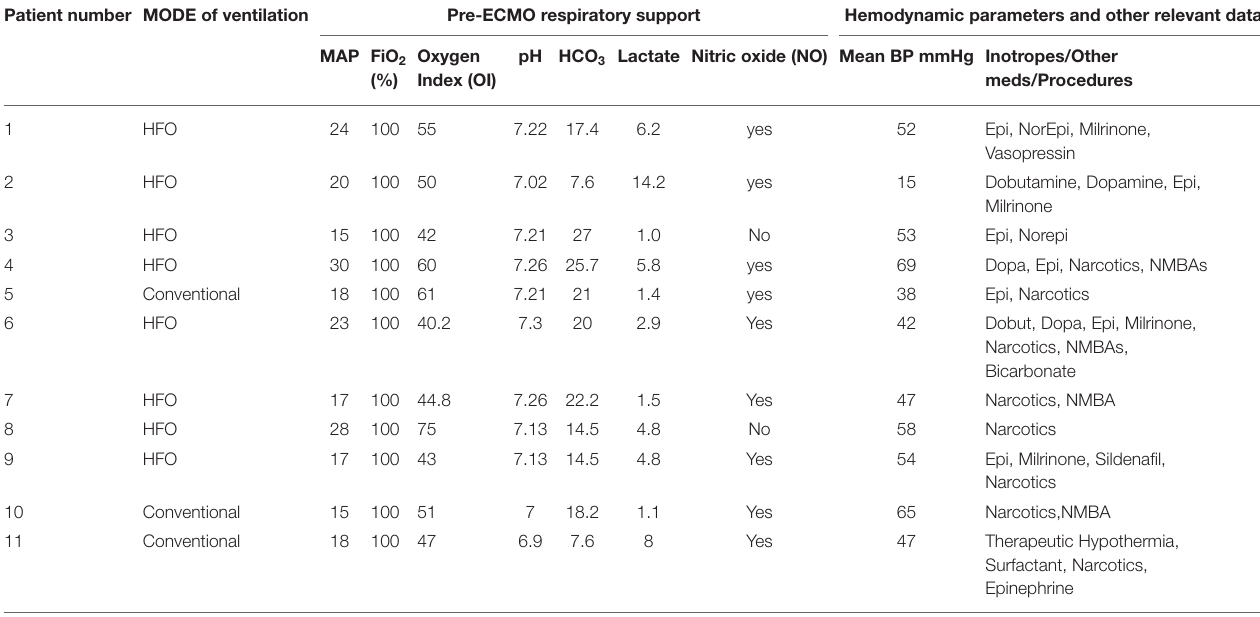
TABLE 1B | Pre-ECMO settings at Sidra Medicine in included patients. Patient number MODE of ventilation Pre-ECMO respiratory